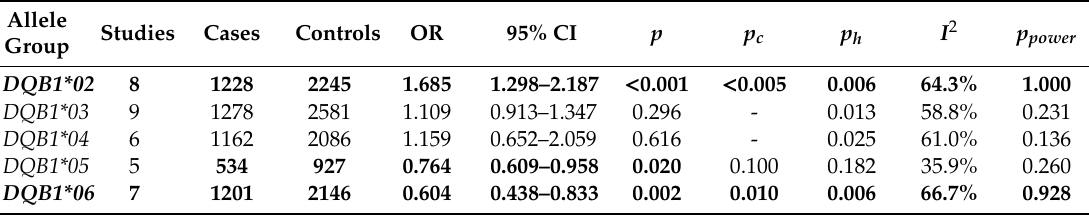
Table 2. Meta-analysis of the association between HLA-DQB1 polymorphisms and susceptibility to LADA.